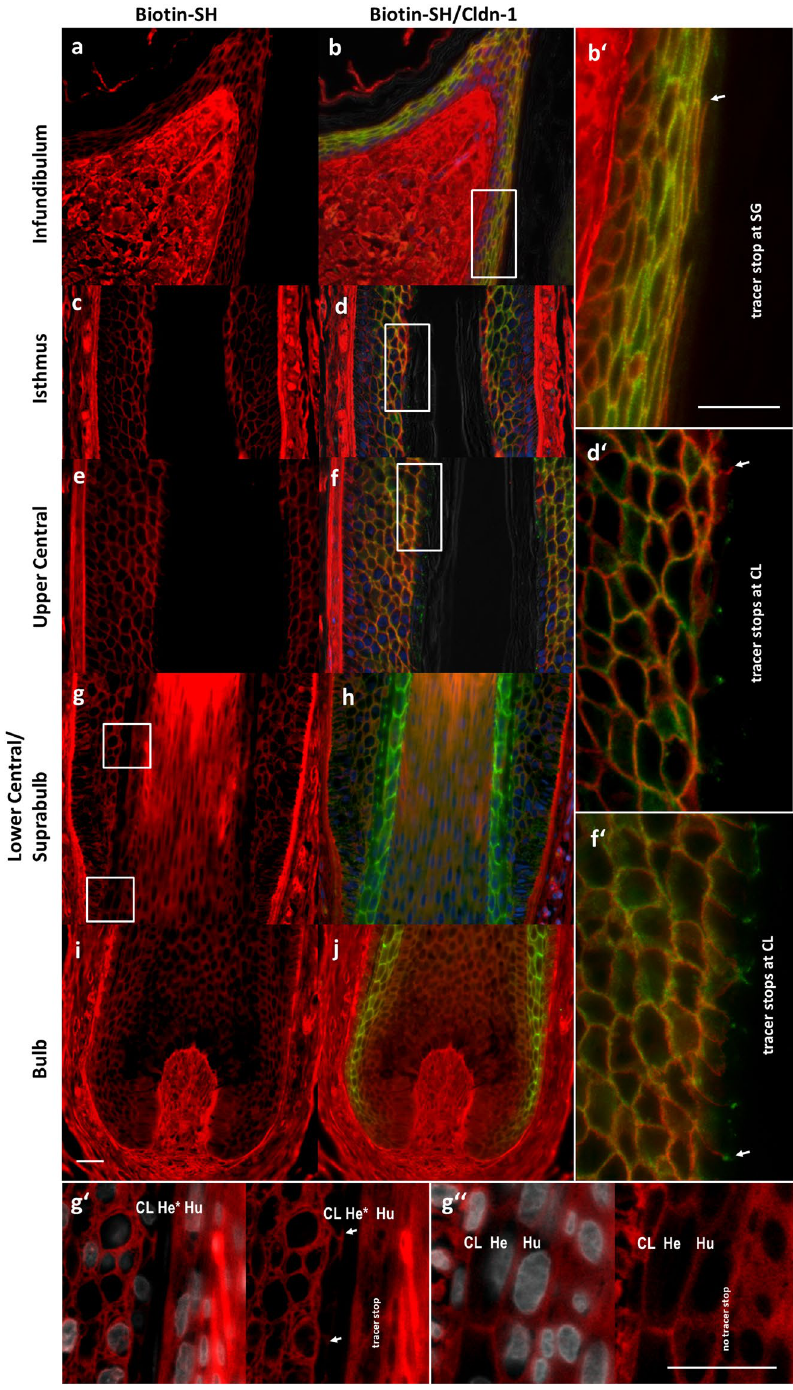
Figure 1. Localization of Cldn-1 and TJ barrier in human anagen HFs. Immunohistochemical stainings of Biotin-SH (red; all pictures) and Cldn-1 (green; b ,b ′ , d ,d ′ , f ,f ′ , h ,and j in an overlay with Biotin-SH) in epidermis and infundibulum ( a,b ,b ′ ), isthmus region ( c,d, d ′ ), central/suprabulbar region ( e,f , g ,g ′ , g ′′ , h ) and in bulbar region ( i , j ) of anagen HFs. (b ′ ,d ′ and f ′ ) represent magnifications of ( b , d and f ) demonstrating localization of the tracer stop in the SG of the infundibulum and CL of isthmus and central region (arrows indicate exemplarily one stop in each picture). (g ′ and g ′′ ) represent magnifications of the boxed areas in g (g ′ : upper box; g ′′ : lower box), and are overlay images of Biotin-SH (red) and DAPI (white) (left pictures) or Bitoin-SH alone (right pictures) showing tracer stop at Huxley’s layer and at the CL of the ORS (arrows) above keratogenous zone at Adamson’s fringe with differentiated Henle’s layer cells (g ′ ), whereas below no tracer stop was found (g ′′ ). (CL: companion cell layer; He: Henle’s layer; He * : differentiated Henle’s layer; Hu: Huxley’s layer). Scale bars: 20 µ